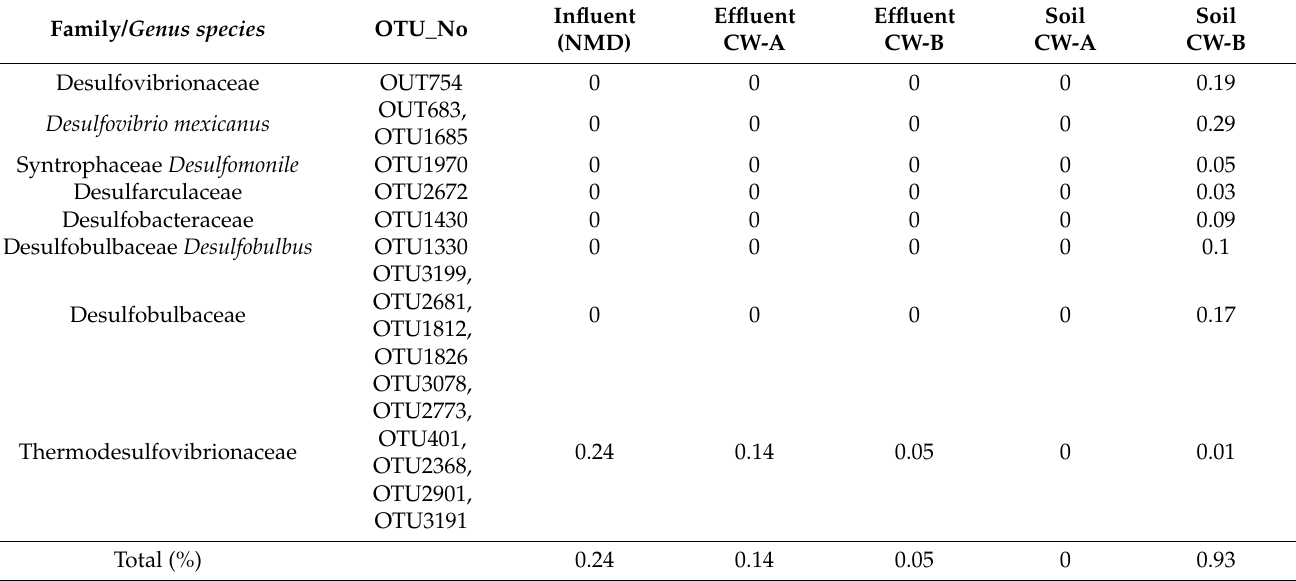
Table 3. Typical SRB (%) detected in water and soil samples of CWs treating